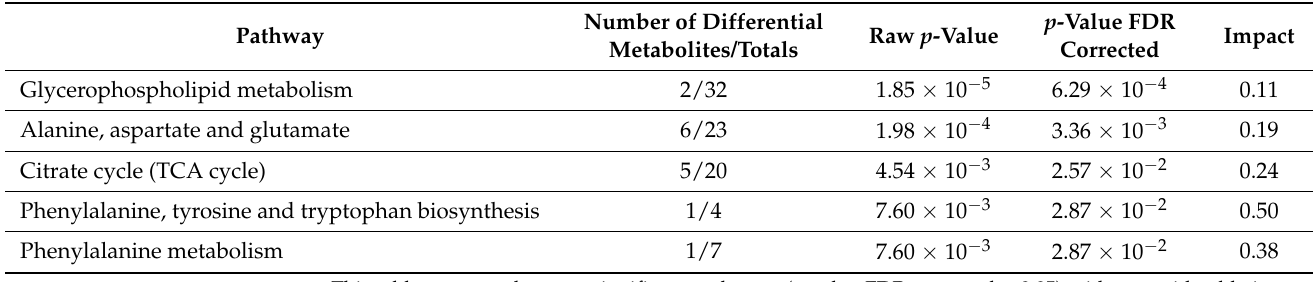
Table 3. Most relevant pathways altered in 15-day-old compared to 1-day-old DJ-1 β mutants.